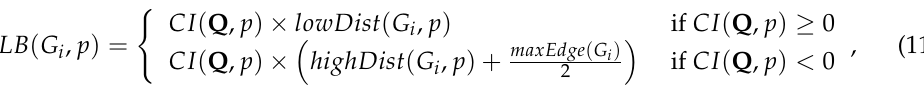
Figure 7. Case 2 of lowDist ( G i , u ). Theorem 3. lowDist ( G i , u ) must be a non-negative number less than or equal to the distance from u to any given vertex in G i . Proof. Please see Appendix C. □ If u belongs to G i , as shown in Figure 8, we let G i equal G n ( v ), such that highDist ( G i , u ) is the distance traveled from u to G x ( u ), G x − 1 ( u ), …, G 1 ( u ), G 1 ( v ), G 2 ( v ), …, G n ( v ) plus high ( G i ). Otherwise, as shown in Figure 9, highDist ( G i , u ) is the distance traveled from u to G x ( u ), G x − 1 ( u ), …, G 1 ( u ), G i plus high ( G i ).